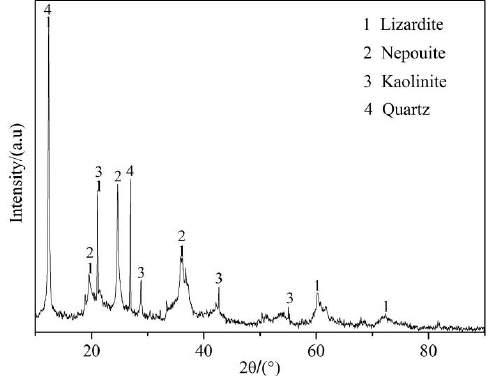
Figure 2. X-ray diffraction (XRD) patterns of garnierite . Figure 2. X-ray di ff raction (XRD) patterns of garnierite. Table 1. The composition of the garnierite (wt. %). Table 1. The composition of the garnierite (wt. %).